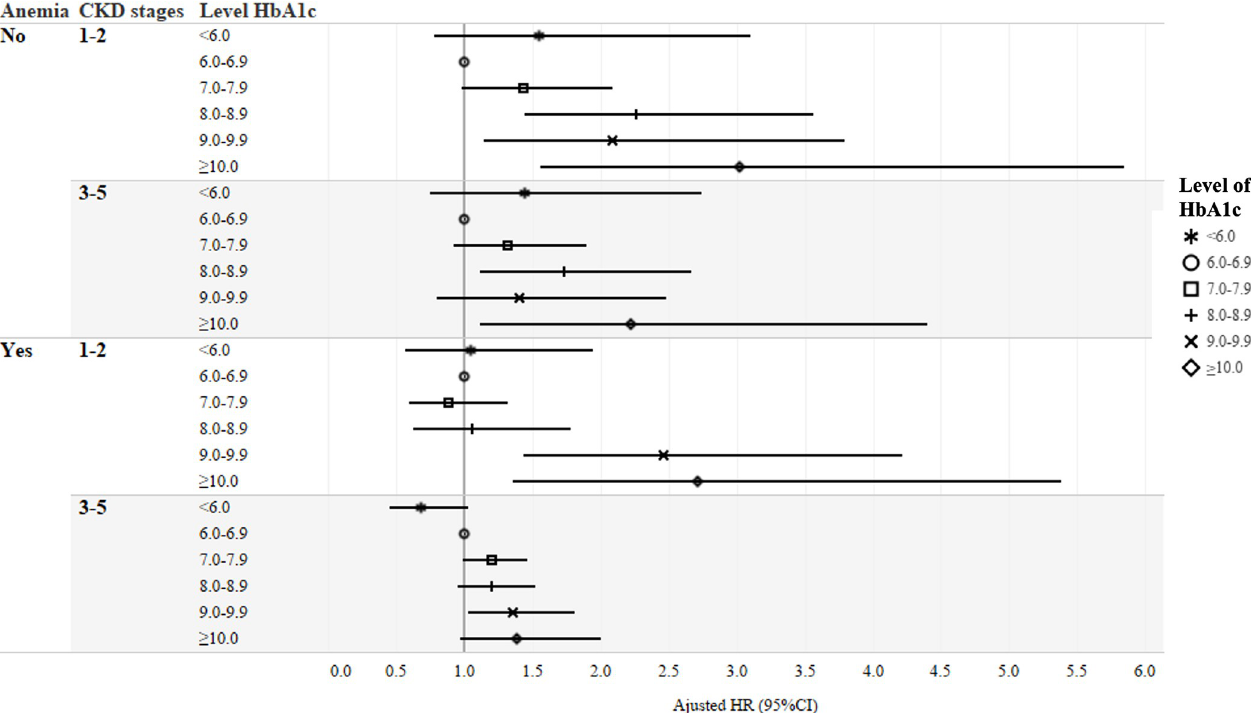
Fig 2. Relative hazards of cardiovascular mortality by different mean HbA1c levels with stratification by anemia and chronic kidney disease staging status.